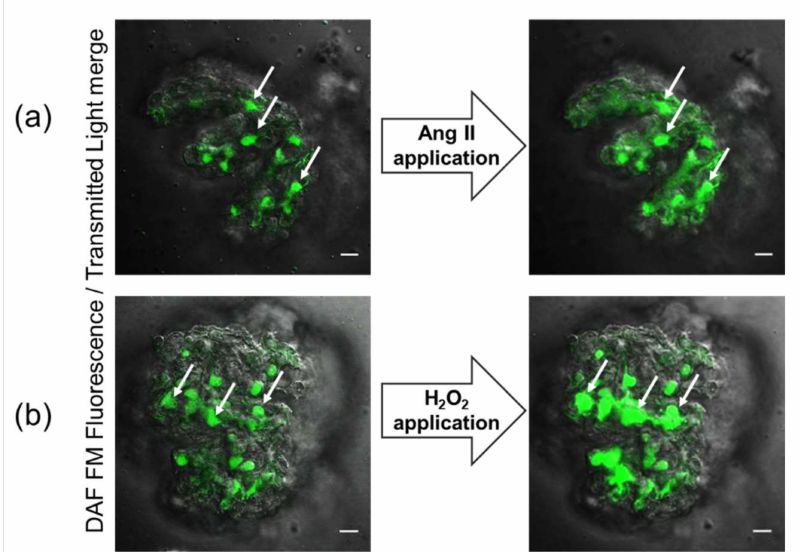
Figure 1. Merged fluorescent and transmitted light images of freshly isolated decapsulated glomeruli loaded with DAF-FM dye (ex. 488, em. 510/20 nm). Microphotographs show the surface localization of podocytes in the glomerulus. Confocal imaging of glomerulus before (left panels) and after (right panels) application of Ang II ( a ) or H 2 O 2 ( b ) provoke elevation of intracellular NO levels in podocytes. Arrows denote podocytes discernable by their morphology and location. The scale bar is 20 µ